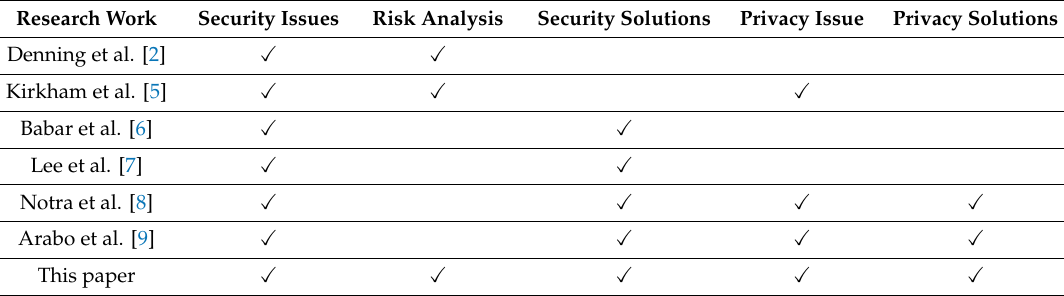
Table 1. Contribution of our survey in related to existing